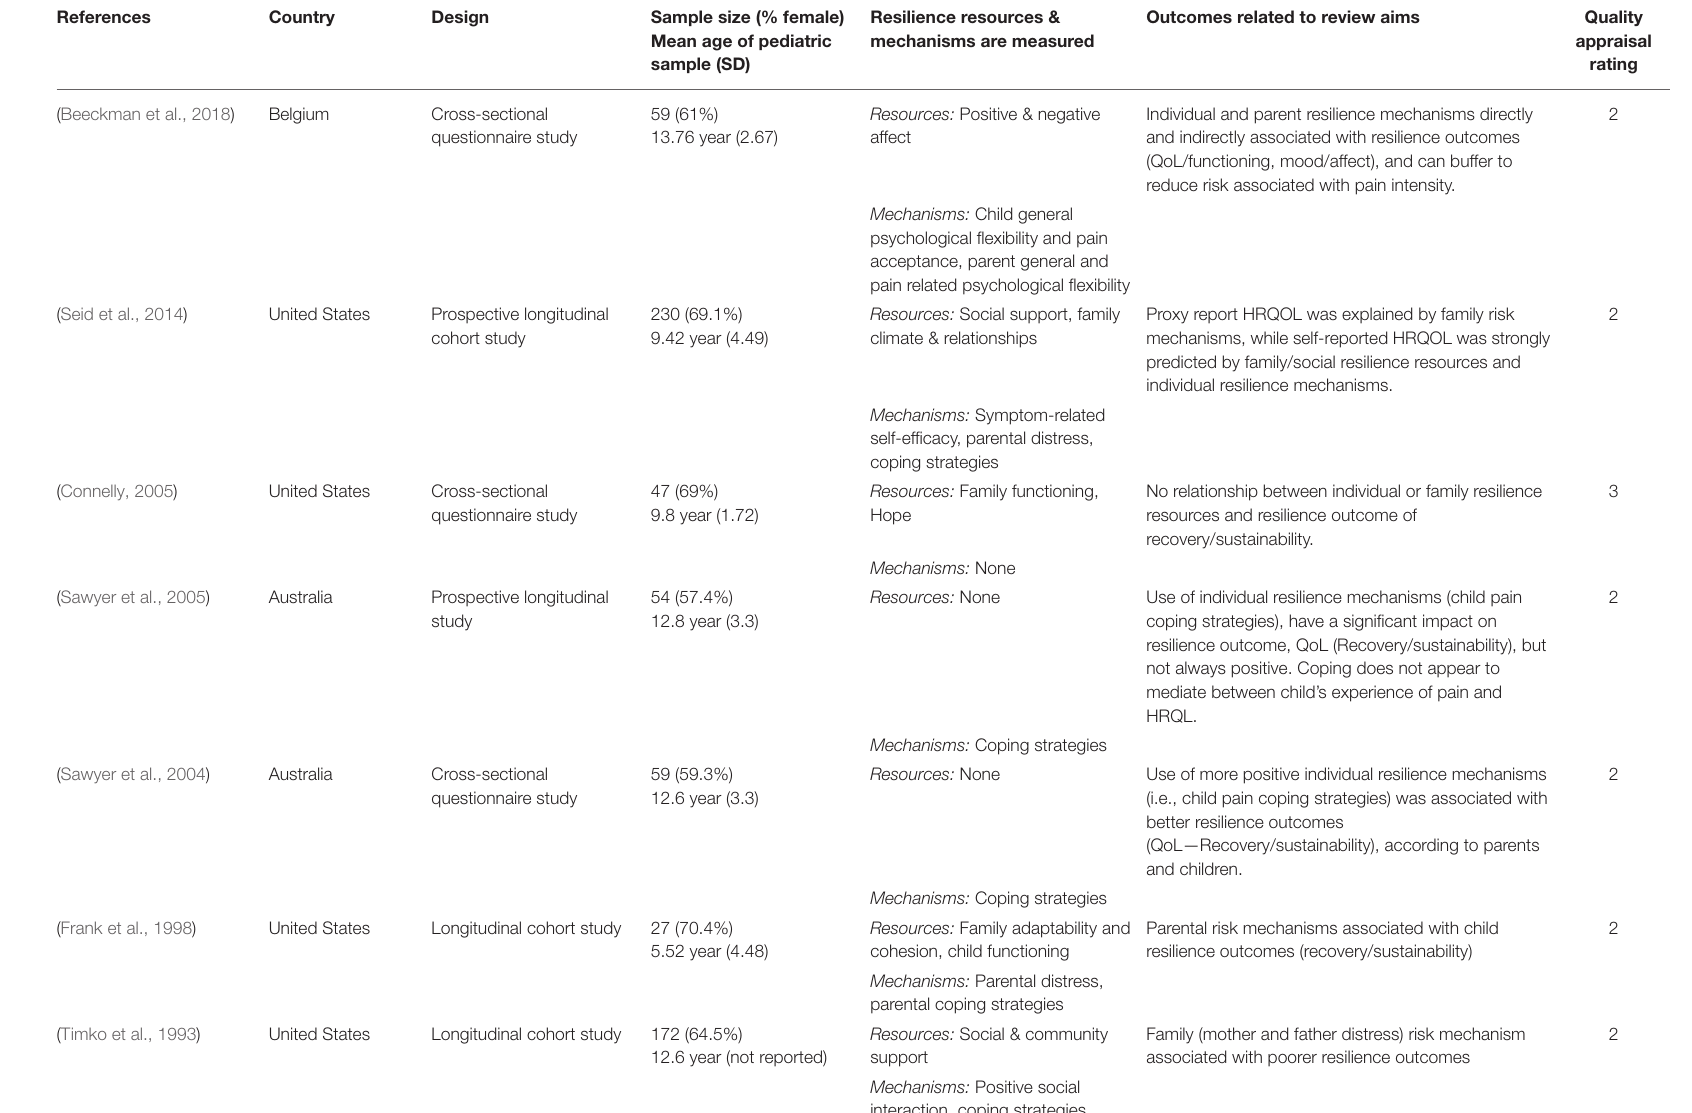
TABLE 1 | Characteristics of